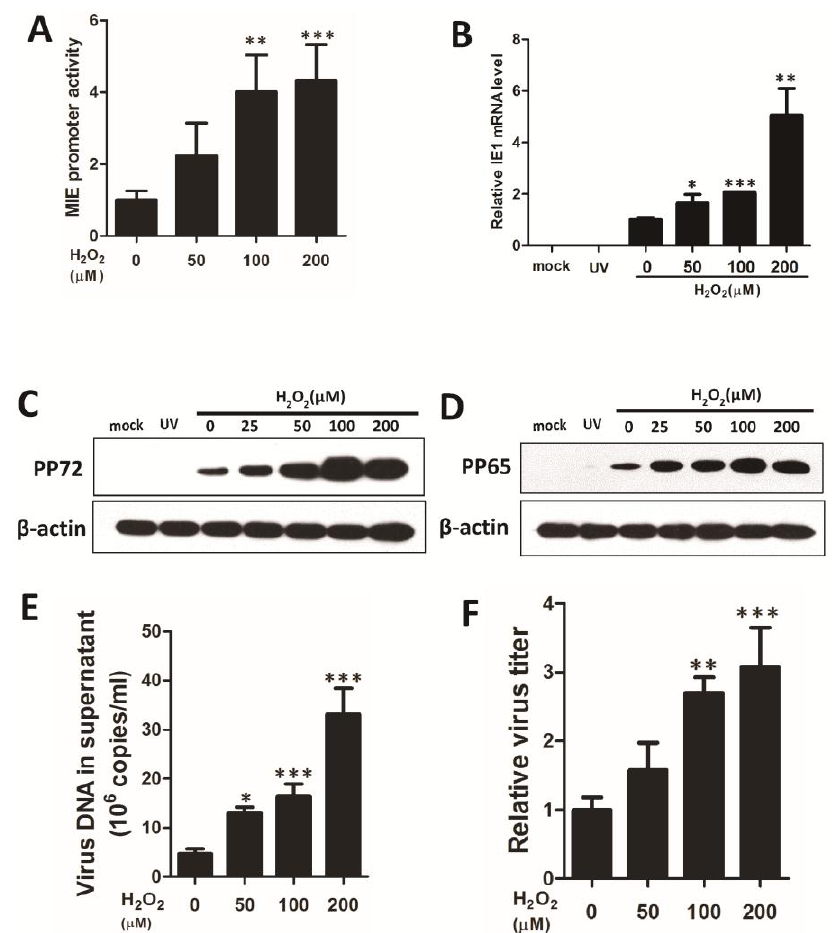
Figure 2. Exogenous H 2 O 2 induces HCMV replication in HFF cells. Luciferase activities were measured for 293 cells transfected with promoter reporter plasmids for 24 h and treated with H 2 O 2 (0, 50, 100, 200 μM) for 12 h ( A ). Cells were infected with UV-HCMV (UV) or HCMV at a multiplicity of infection (MOI) of 0.5. Incubation with exogenous H 2 O 2 (0, 50, 100, or 200 μM) for 24 h induced the expression of immediately early (IE1) transcript in HCMV infected cells ( B ). Proteins were collected from infected cells for treatment with 0, 25, 50, 100, 200 μM H 2 O 2 for 72 h. Viral proteins pp72 ( C ) and pp65 ( D ) were detected by Western blotting using β-actin for calibration of sample loading. Viral DNA load and viral titer and were measured after a 72 h treatment with 0, 50, 100, or 200 μM H 2 O 2 by real-time quantitative PCR ( E ) and TCID 50 assay ( F ). * p < 0.05; ** p < 0.01 or *** p < 0.001 for treated versus untreated cells.